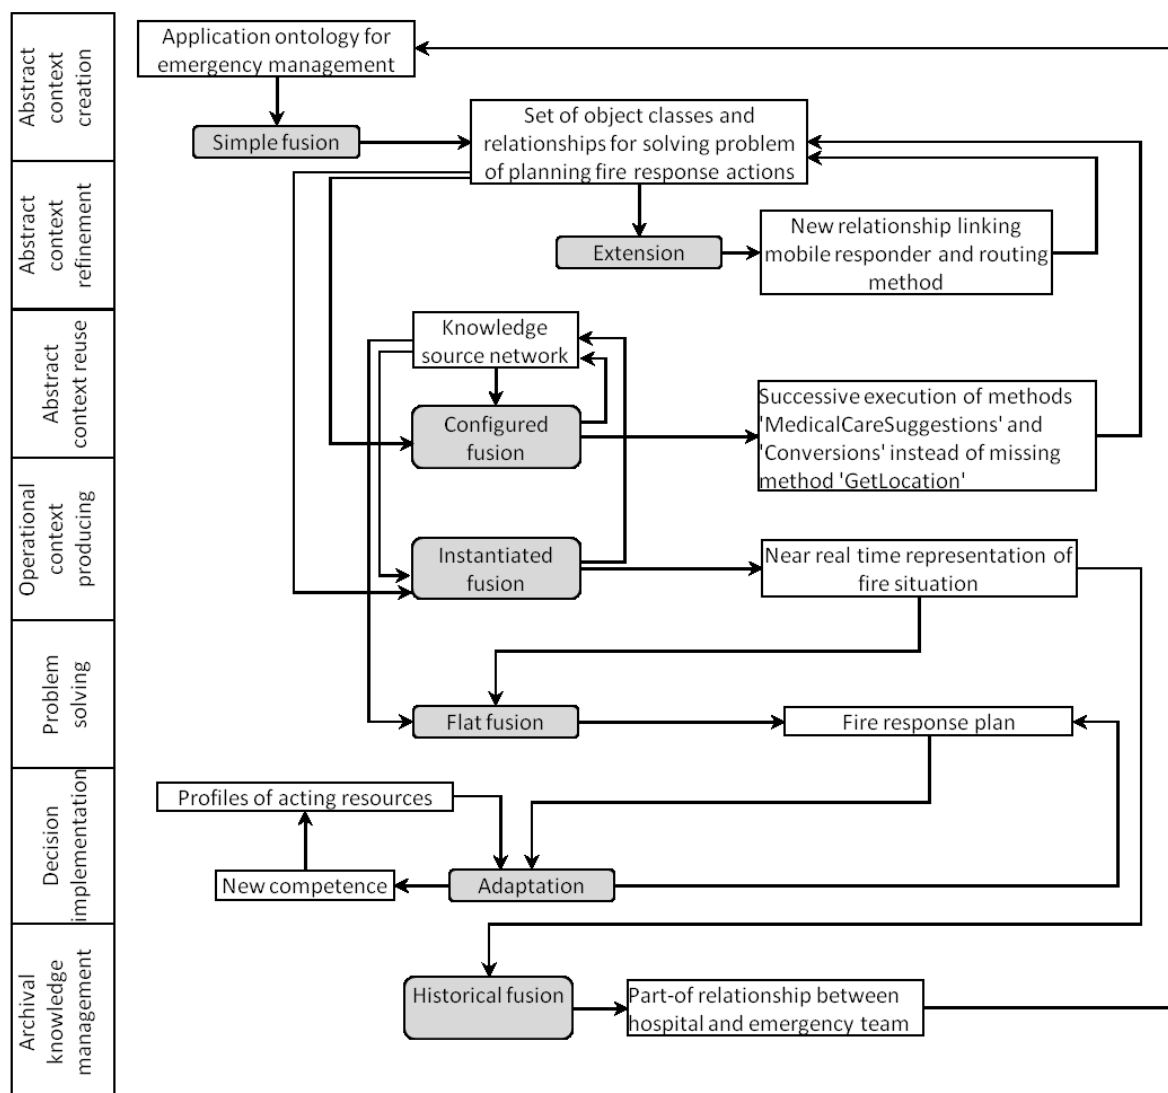
Figure 6. Usage of knowledge fusion patterns for planning fire response